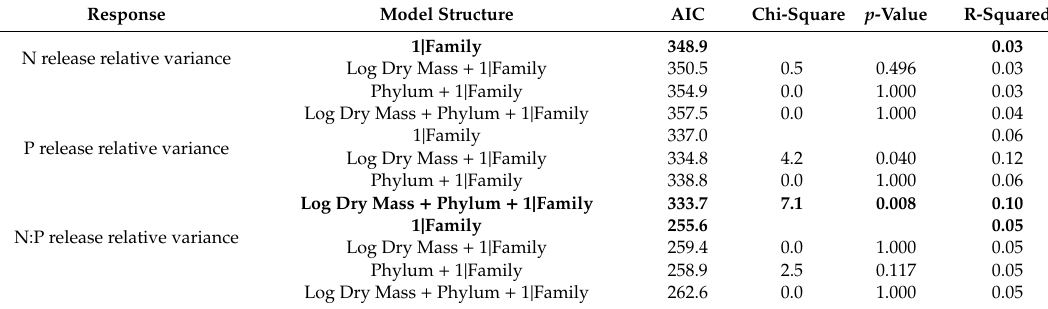
Table 3. Summary of weighted mixed e ff ects models used to predict N, P, and N:P release relative variance of egestion compared to excretion across animal taxa. Best-fit models based on lowest AIC scores are highlighted in bold. Only models predicting relative variance based on inorganic nutrient excretion were compared. See Table S2 for best-fit model global